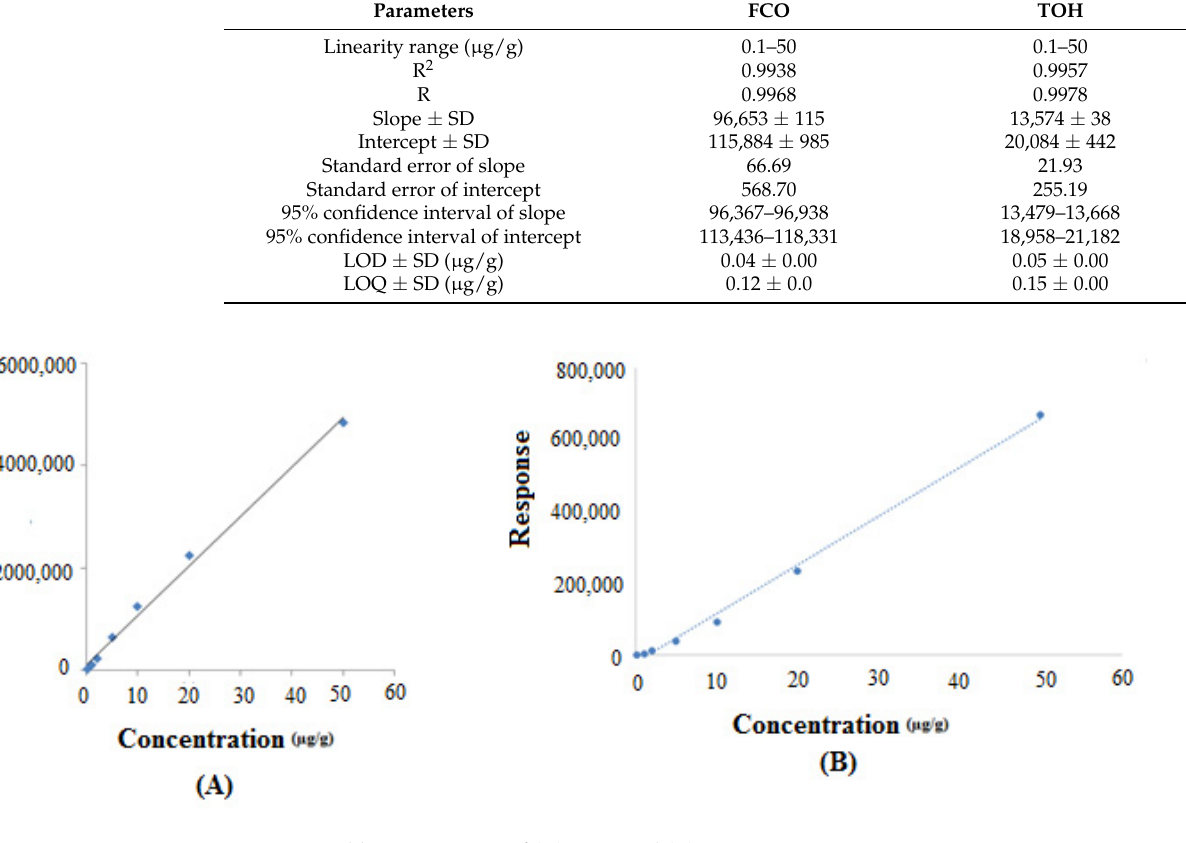
Figure 4. Calibration curves of ( A ) FCO and ( B ) TOH.